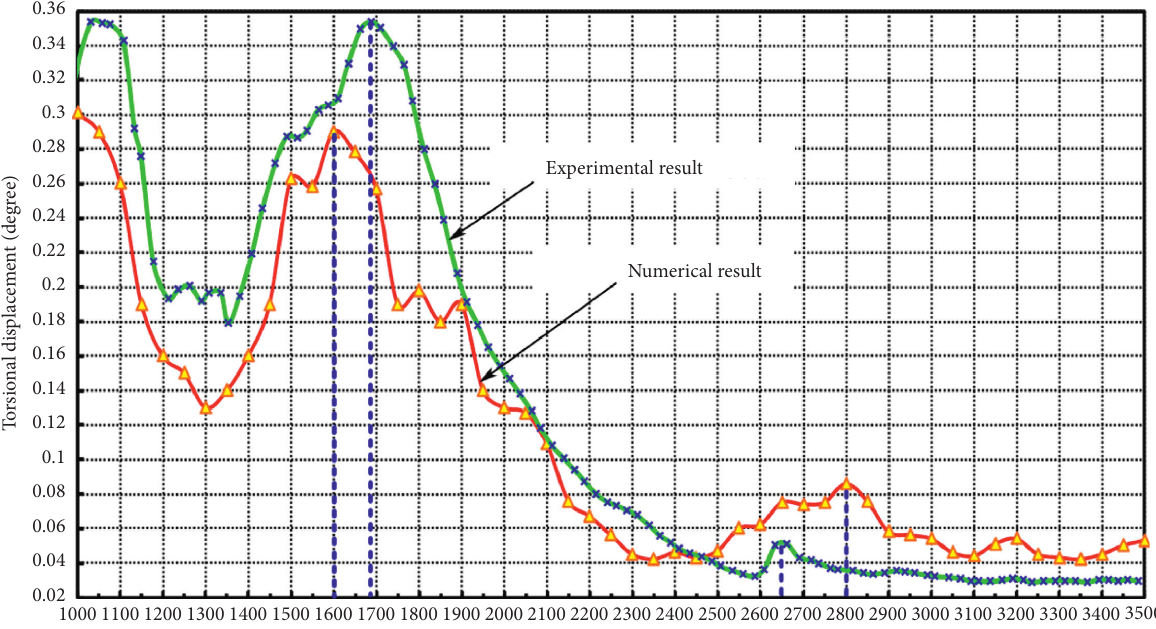
Figure 11: Comparison of numerical and experimental results for input end of rear axle.